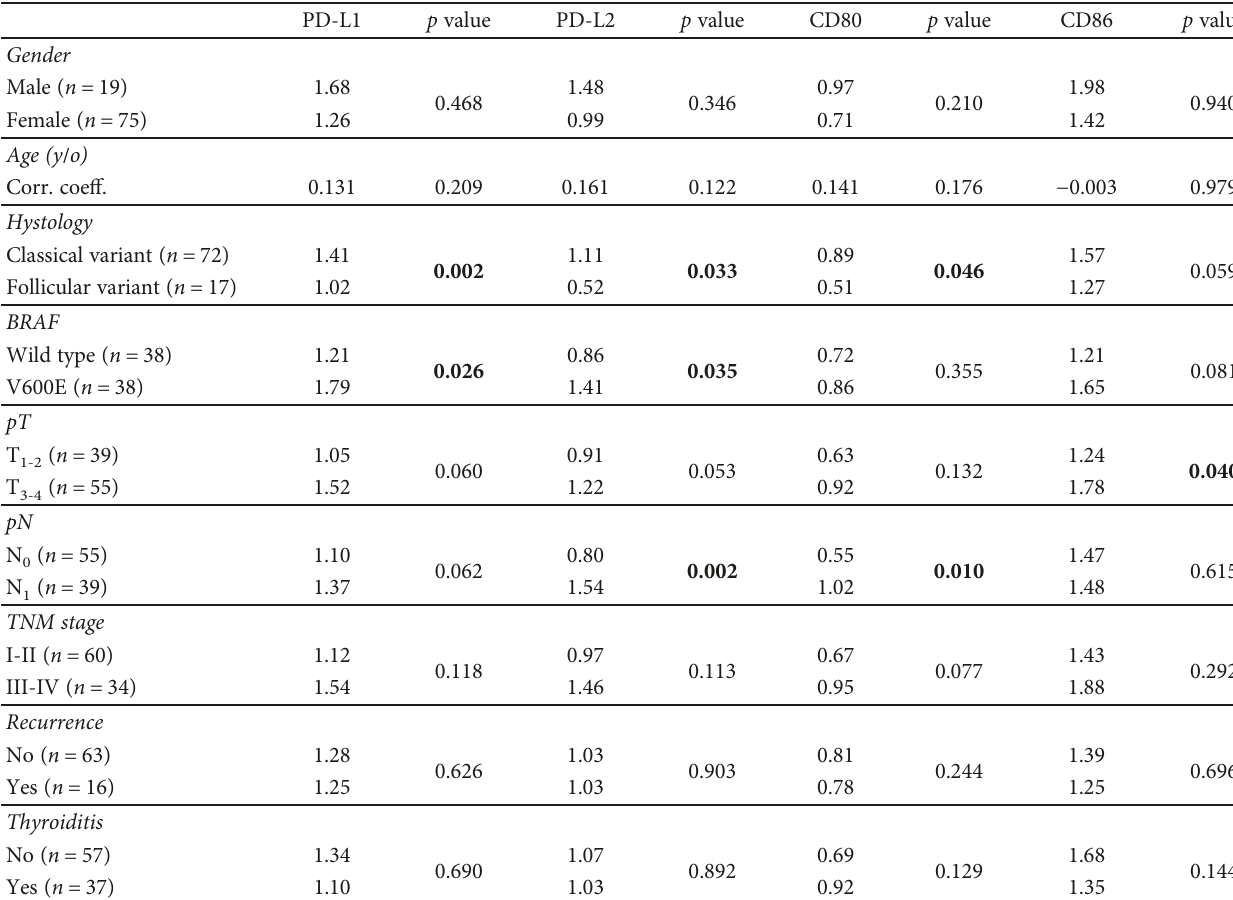
Table 3: Univariate statistical analysis of PD1 and CTLA4 ligand gene expression and PTC patient characteristics and clinicopathological features. For each clinicopathological feature, the number of patients in each group was reported in brackets. For each gene, the median value of mRNA fold change between PTC tissue and its normal counterpart is